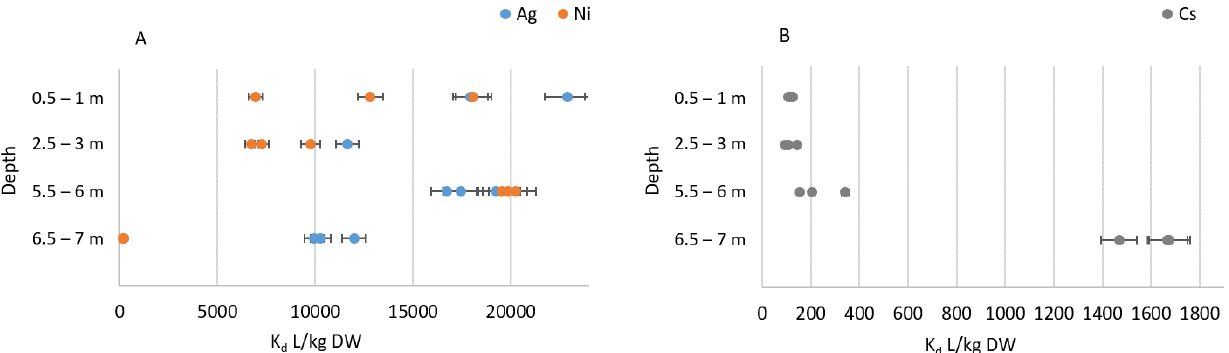
Figure 2. Ag, Ni ( A ) and Cs ( B ) K d values (L/kg DW) in fresh Lastensuo bog samples from 0.5–1 to 6.5–7 m. Layers from 0.5 m to 3.0 m consisted of peat, layer 5.5 m of gyttja, and layer 6.5 of clay. Error bars indicate 5% measurement uncertainty. The figure shows all three parallel samples.